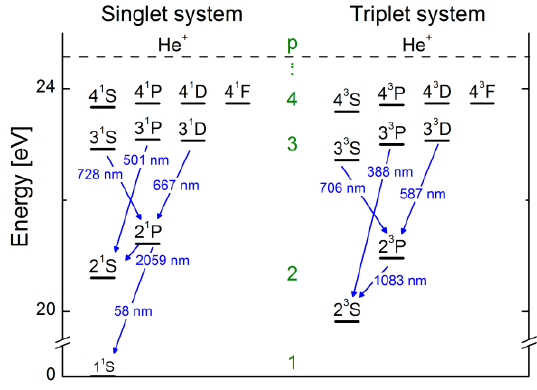
Figure 1. Energy-level diagram of the helium atom.